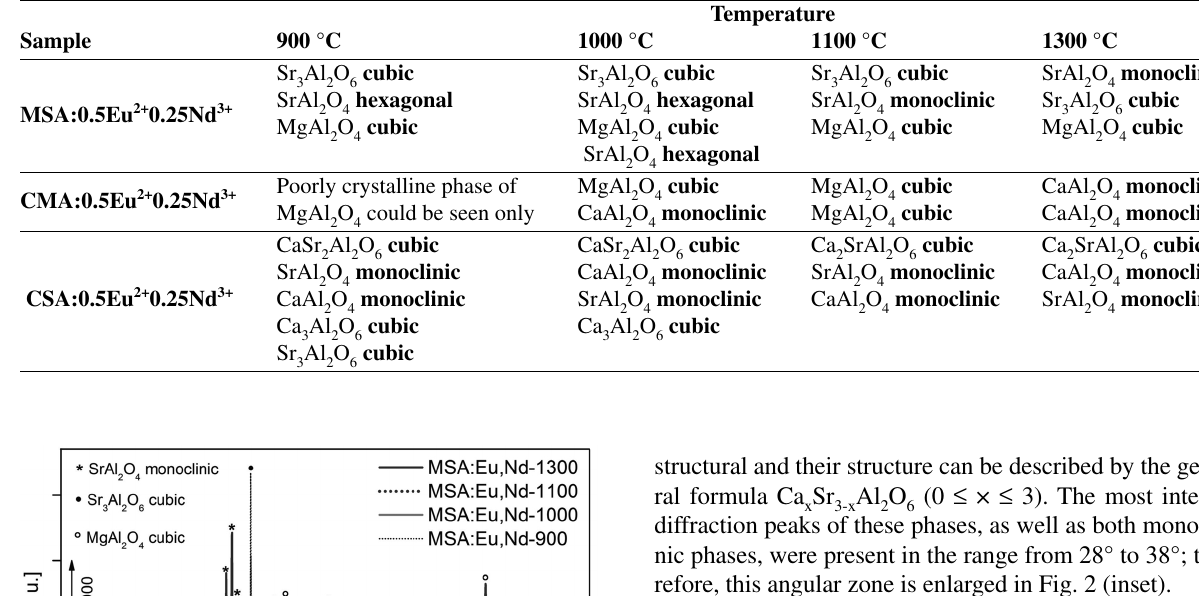
Table 1. Selected results of the Search Match analysis.